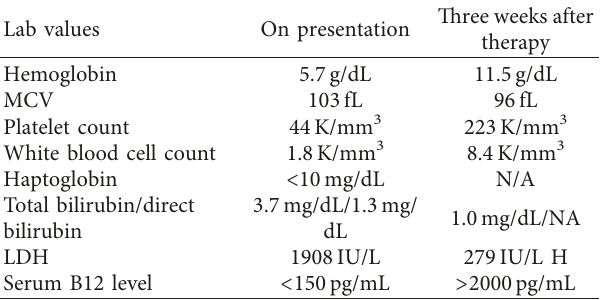
Table 1: Lab values before and after therapy.